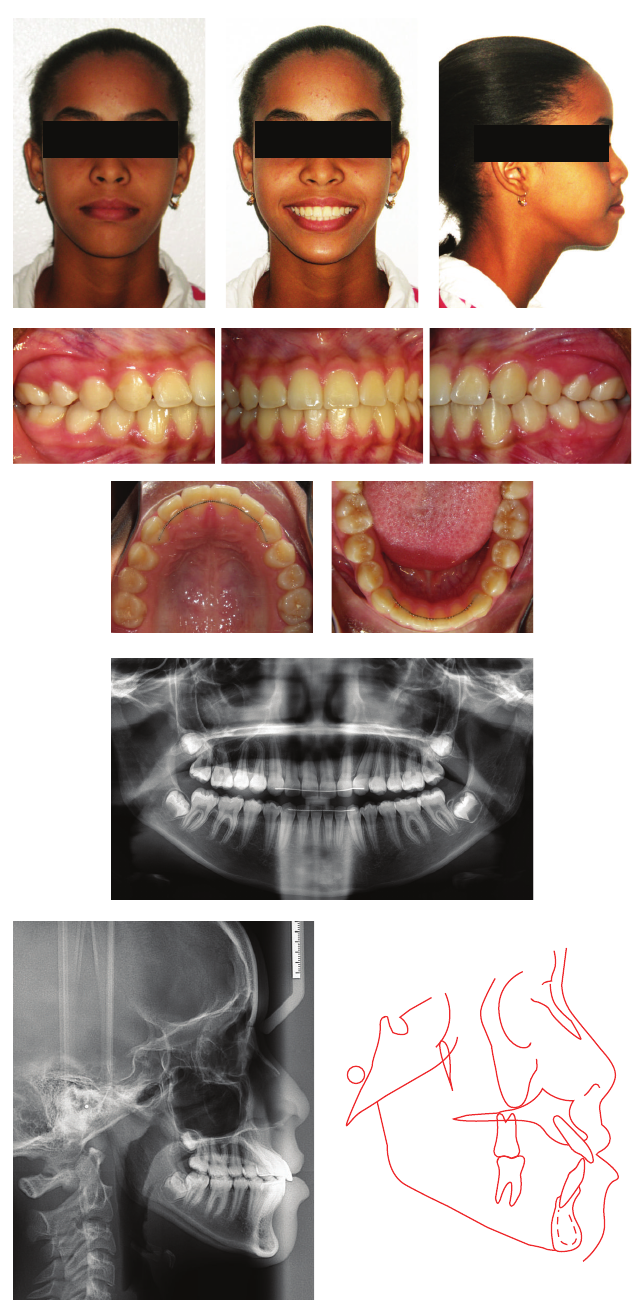
Figure 4: Posttreatment photographs and